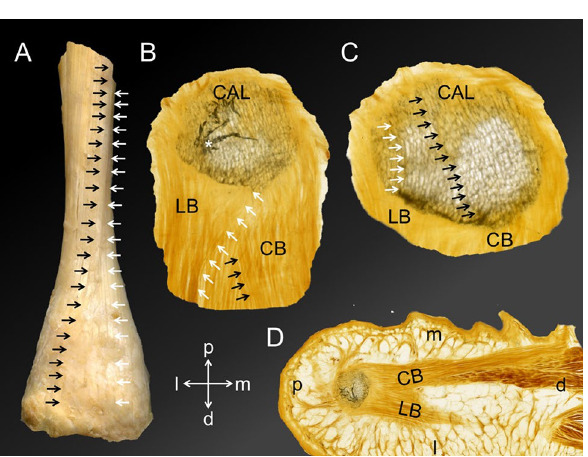
Figure 6. The course of both Achilles tendon (AT) and plantar fascia (PF) collagen fascicles is depicted . ( A ) A dissected AT is shown from dorsally. The black arrows indicate a collagen bundle running from proximal medial to distal lateral in the superficial AT layer. In contrast, the white arrows indicate that the most medial superficial fascicles of the proximal AT stay medial in the distal part of the AT. ( B ) A plantar view on the most inferior tip of the calcaneus (CAL) is displayed with the inserting lateral (LB) and central bundle (CB) of the PF. The white arrows point on collagen fibres that originate from the medial CAL taking a course towards the LB. Inversely, a number of fibres can be observed taking a medially directed course (indicated by the black arrows). The white asterisk indicates a bony artefact. ( C ) A plantar view on the CAL is displayed at a slightly more proximal level compared to B. Focusing on the trabecular architecture, the black arrows indicate representative trabeculae that take a lateromedial course, similar to the more distal fibres of the CB shown in B. Similarly, the white arrows highlight representative trabeculae that are in line with the orientation of the LB. ( D ) An overview of the slice shown in B is depicted, showing the CB and LB originating from the CAL taking a distal course (view from plantar). Directions A-C: indicated by a cross; d, distal; l, lateral; m, medial; p,